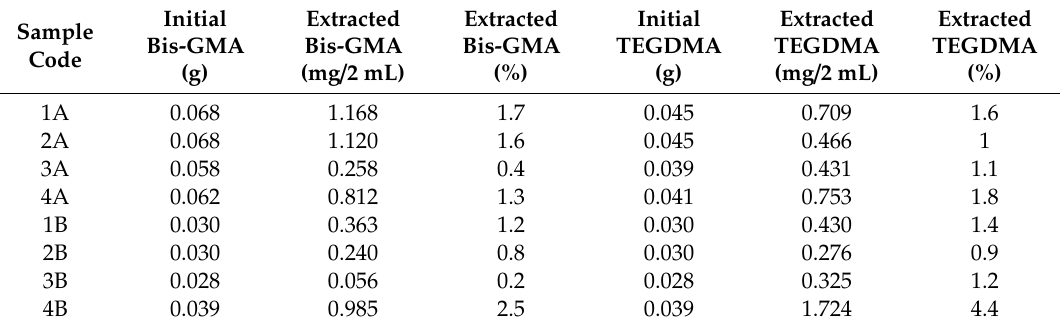
Table 2. The percentages of extracted Bis-GMA and TEGDMA